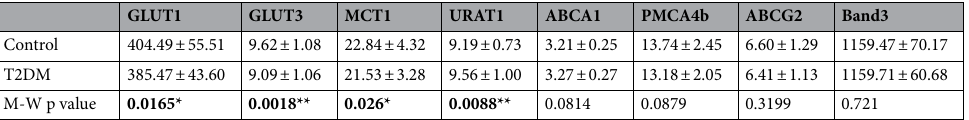
Table 2. Expression of RBC membrane proteins in age-matched controls and in T2DM patients, measured by flow cytometry. The protein expression values, calculated as described in the “Methods” section, are expressed as means ± SD. The p values were calculated by the Mann–Whitney test. n = 59 for all controls, except for MCT1 (n = 54), and n = 120 for all T2DM patients, except for MCT1 (n = 109).